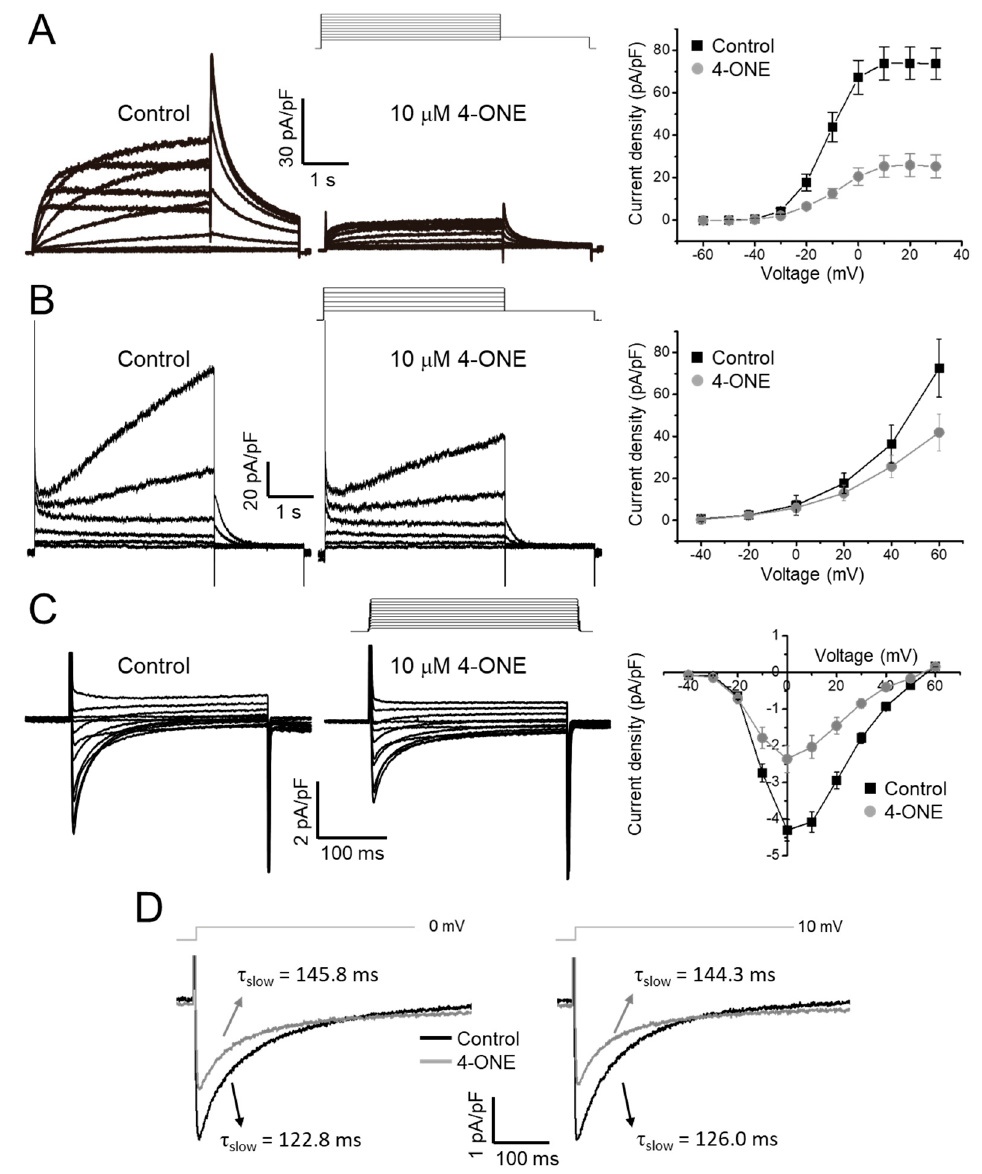
Figure 4. Effects of 4-ONE on cardiac ionic currents. ( A ) Human Ether-a-go-go Related Gene (hERG) K + current (I Kr ) was inhibited by 4-ONE in hERG-overexpressing HEK cells. I Kr was activated by depolarization from − 60 to 30 mV, followed by repolarization of − 40 mV evoked the maximum I Kr activity, and the peak I Kr was plotted to I–V relationship curve. ( B ) Slowly activating voltage-dependent K + current (I Ks ) was recorded from KCNQ1/KCNE1 -overexpressing HEK cells. I Ks was activated by depolarization from − 40 to 60 mV. The maximum I Ks was analyzed with I–V relationship curve. ( C ) L-type Ca 2+ current (I Ca,L ) was activated by applying from − 40 to 60 mV of depolarization potentials from − 50 mV of holding potential in guinea-pig ventricular myocyte (GPVM). The peak I Ca,L was plotted to I–V relationship curve. ( D ) The decay of I Ca,L was fitted using a double exponential equation. The slow component of time constant ( τ slow ) of I Ca,L activated by 0 and 10 mV of depolarization potential was indicated.